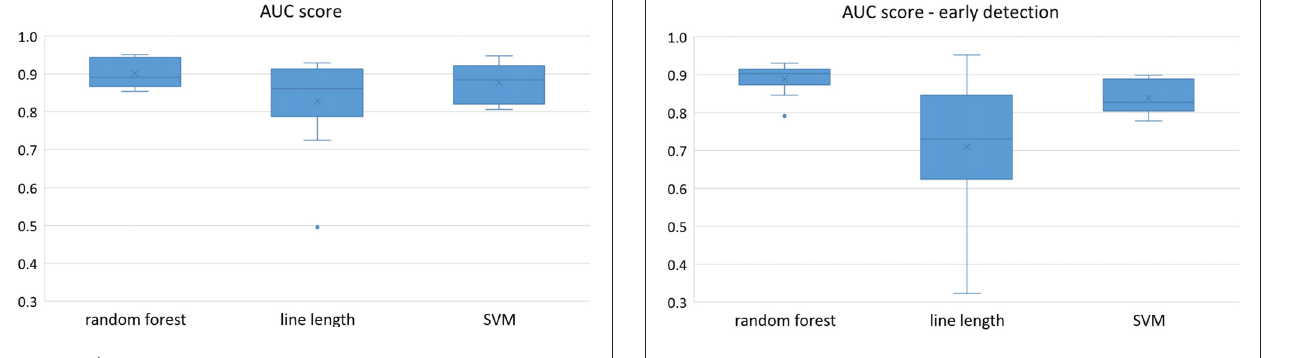
FIGURE 4 | Early detection performance of the classifiers over all the patients in multichannel mode. Here, just the seizures which could be detected in the first 10 s are counted as a true